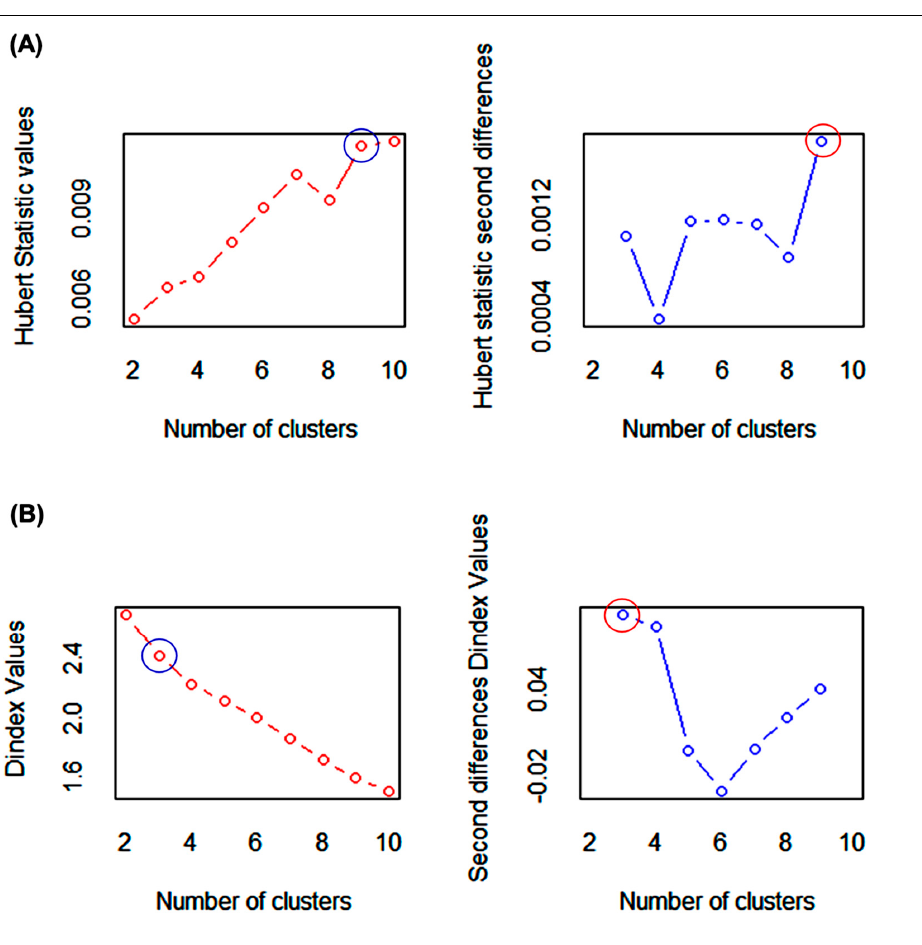
Figure 6. Graphical method ( A ) Hubert index and ( B ) Dindex for detecting the optimum number of clusters.